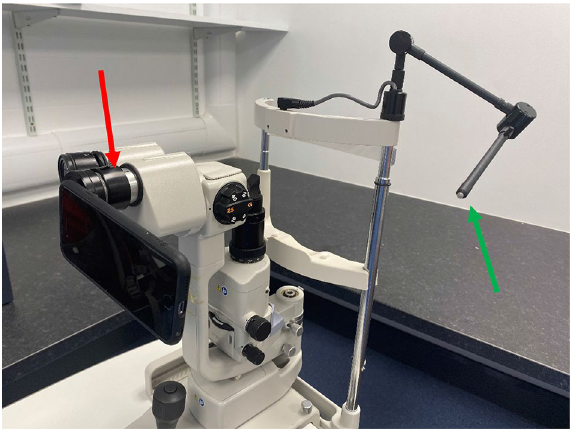
Figure 1. The iPhone 6s, TopCon SL-D4 imaging system with the Zarf bespoke adapter (red arrow) and TopCon external fixation target (green